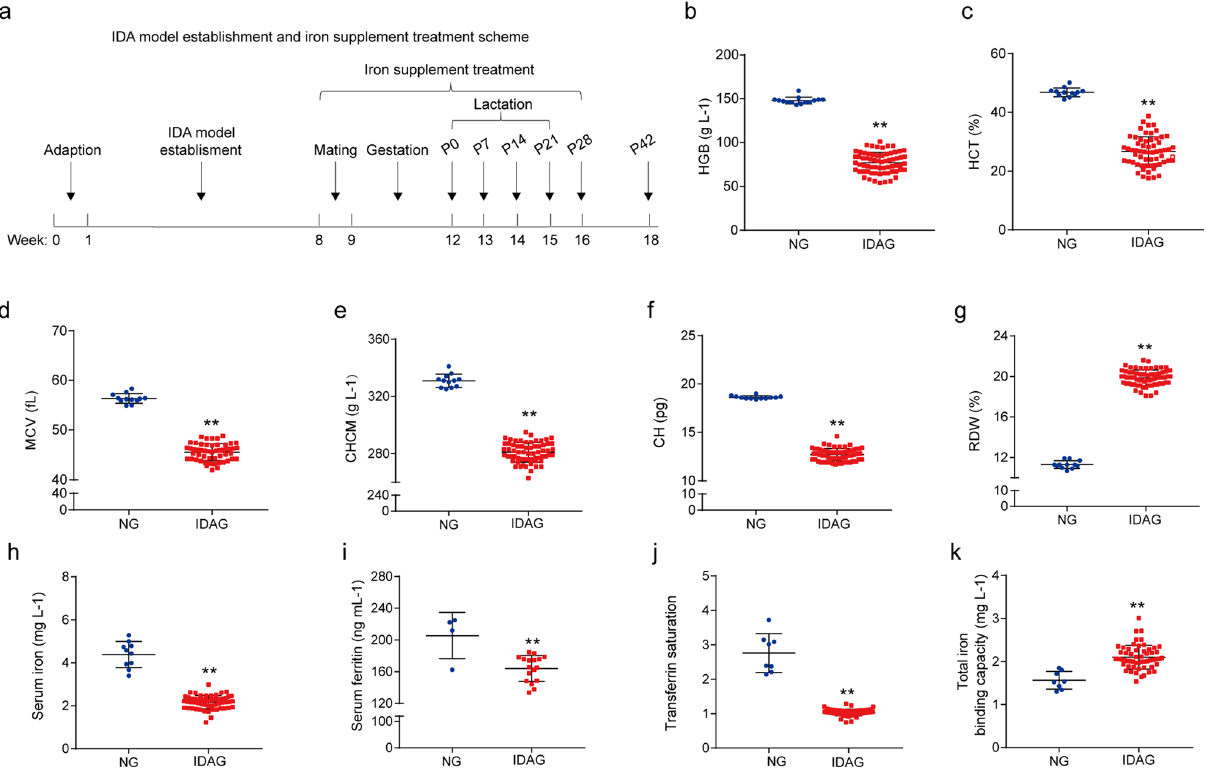
Figure 1. Establishment of iron deficiency anemia model in female rats. ( a ) Scheme of IDA model establishment and iron supplement treatment. The whole blood of maternal rats was collected and haematological indexes were tested. ( b ) HGB. ( c ) HCT. ( d ) MCV. ( e ) CHCM. f CH. ( g ) RDW. The serum of maternal rats was collected and tested. ( h ) SI. ( i ) SF. ( j ) TS. ( k ) TIBC. HGB haemoglobin, HCT Hematocrit, MCV mean corpuscular volume, CHCM cell haemoglobin concentration mean, CH haemoglobin content of red blood cell, RDW red cell volume distribution width, SI serum iron, SF serum ferritin, TS transferrin saturation, TIBC total iron binding capacity. Data are presented as mean ± SD ( n = 12). ** p < 0.01, compared with NG. Unpaired t-test was used for comparison between two